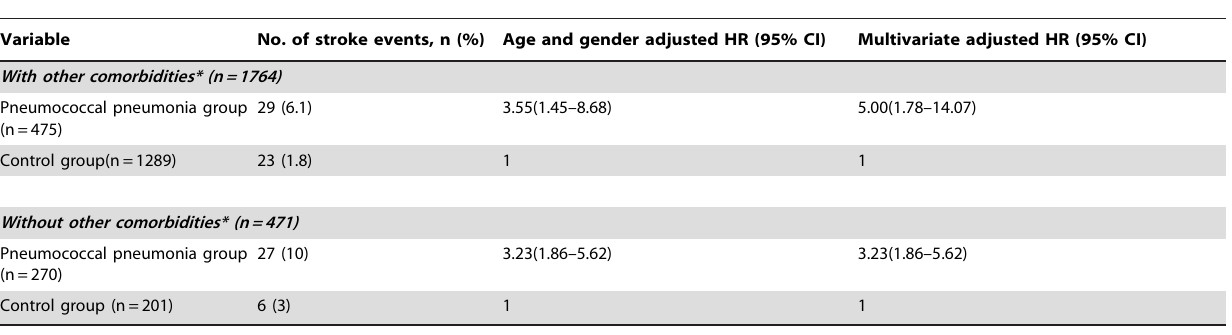
Table 5. Adjusted hazard ratios of stroke events among the individuals with pneumococcal pneumonia and those without pneumococcal pneumonia stratified by comorbidities for the first year of follow-up.